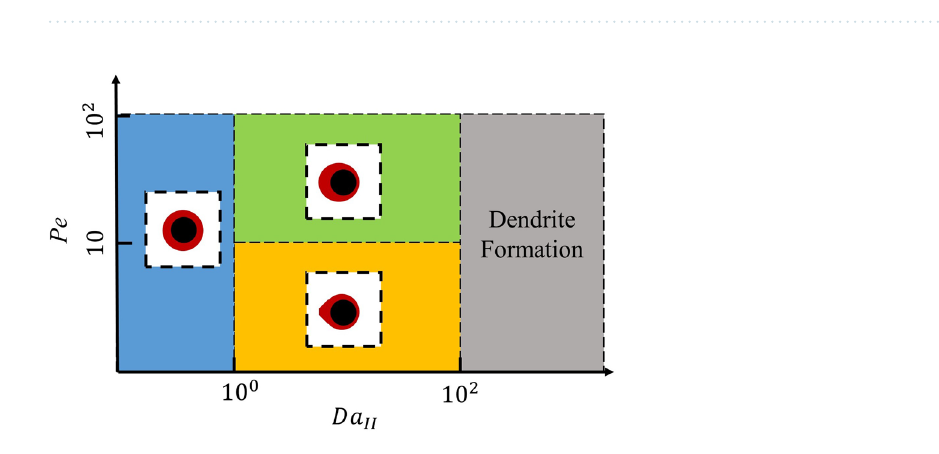
Figure 12. Precipitated solid phase mass as a function of nondimensional time for different Damköhler number at Pe = 1.4.